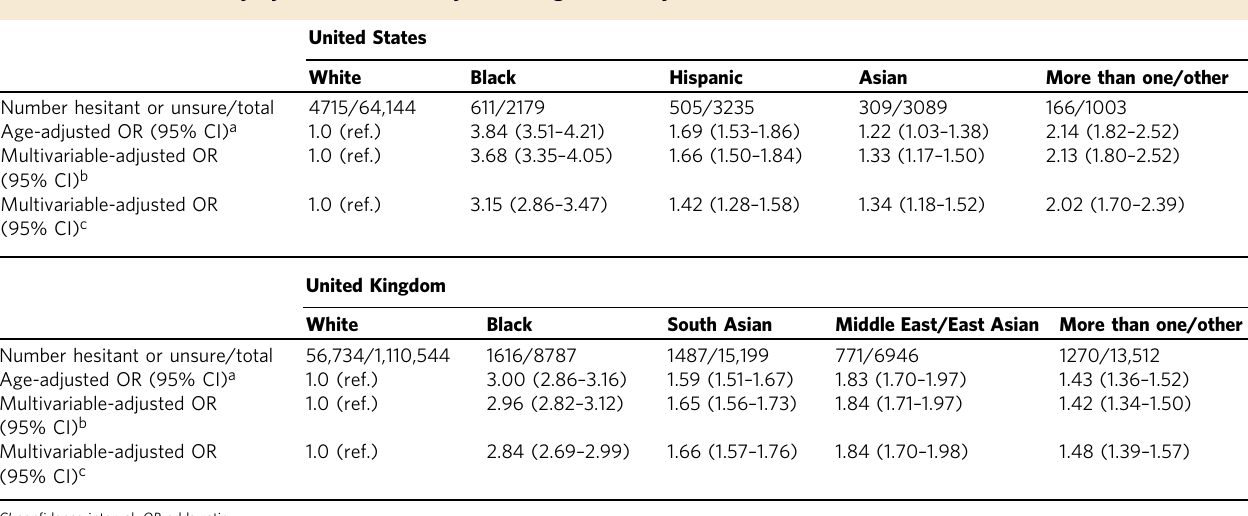
Table 1 Vaccine hesitancy by race and ethnicity according to country of